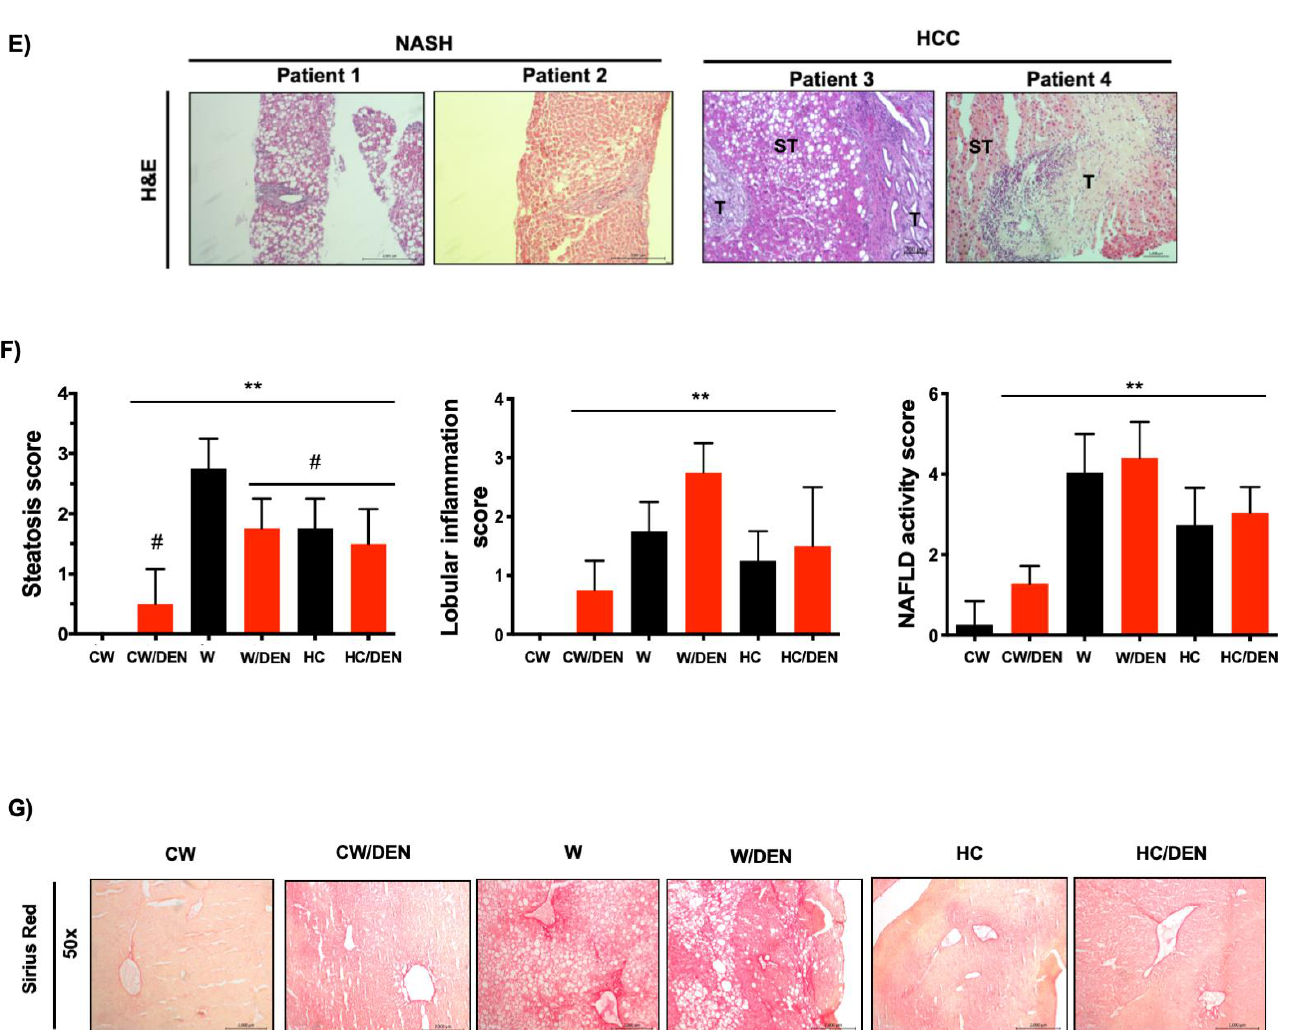
Figure 2. The consumption of a Western diet induces lipid liver overload and hepatic tumors. ( A ) Gross inspection of the livers from mice fed with the different diets and treated or not with DEN. Arrows and arrowheads show tumors. Representative images of at least eight animals per group. ( B ) Liver cholesterol and triglycerides content ( n = 4). ( C ) Number of tumors in livers from different groups of mice. Each graph plots the individual data points, the superimpose horizontal line indicates the arithmetic mean and error bars showing ± SEM ( n = 8). ( D ) mouse and ( E ) human liver tissue histology assessed by routine H&E. Each mouse image is representative of four animals. T, tumor; ST, surrounding tissue. ( F ) histological scores. ( G ) Fibrosis determined by Sirius red staining. Each image is representative of four animals. Each bar is the mean ± SEM. ** p < 0.01 vs. CW group; # p < 0.05 vs. W diet alone